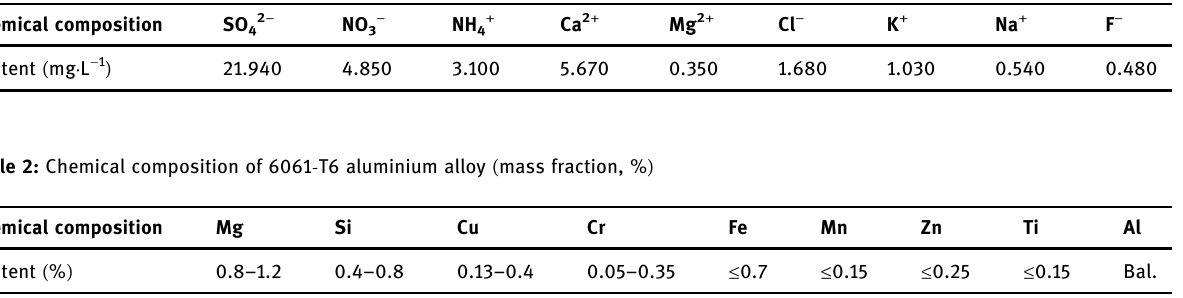
Table 1: Composition of simulated acid rain ( mg · L − 1 )